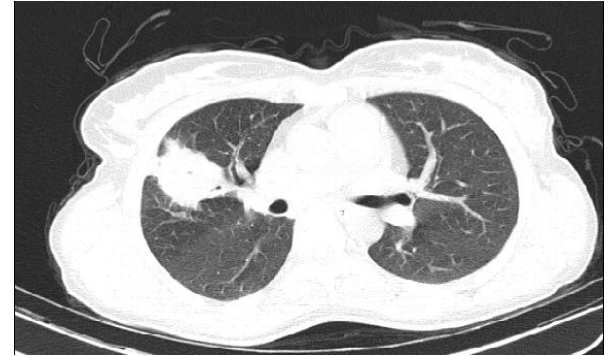
Figure 2. Spiral lung HRCT after 3 months medical